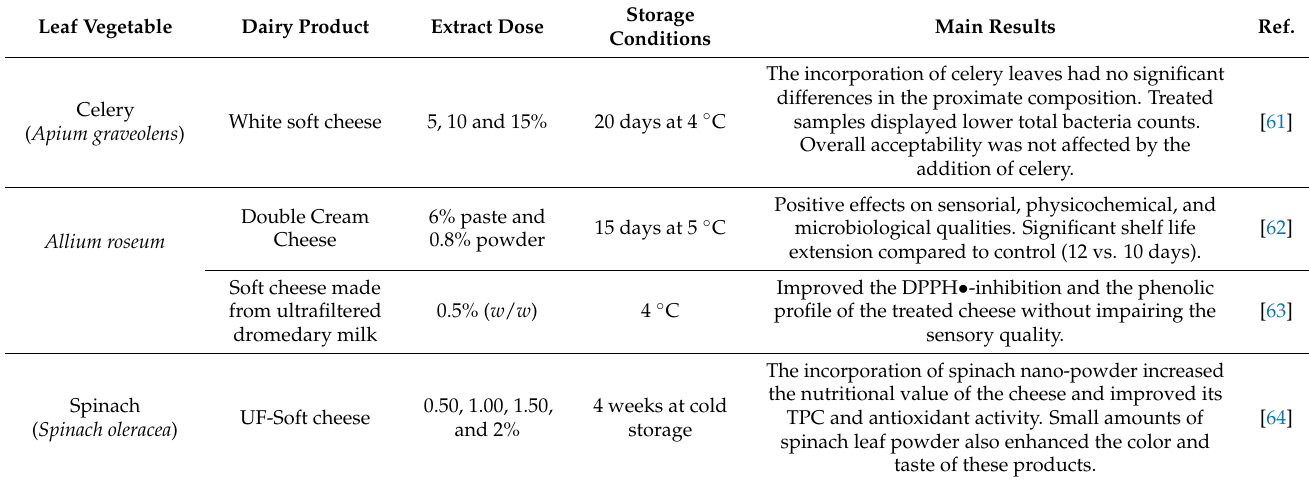
Table 1. Effect of natural extracts obtained from the leaves of different endemic plants on the shelf life of dairy